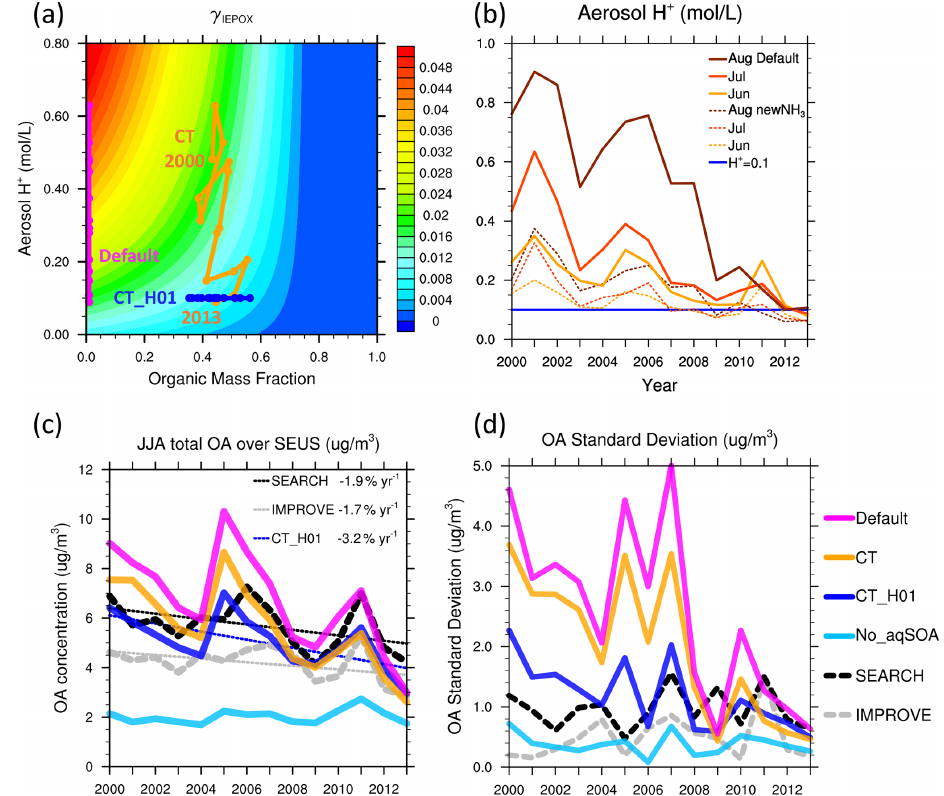
Figure 4. (a) Schematic diagram of IEPOX reactive uptake coefficient ( γ IEPOX ). Colored lines indicate the position of JJA-averaged organic mass fraction and aerosol H + activity in 2000–2013 from the default, CT and CT_H01 simulations. (b) Simulated aerosol acidity (molL − 1 ) from the default, CT_newNH 3 and CT_H01 simulations. (c) JJA-averaged surface OA (µgm − 3 ) from IMPROVE, SEARCH and all model simulations. (d) Standard deviation of OA (µgm − 3 ) between June, July and August from IMPROVE, SEARCH and all model simulations. All results are averaged over the southeast